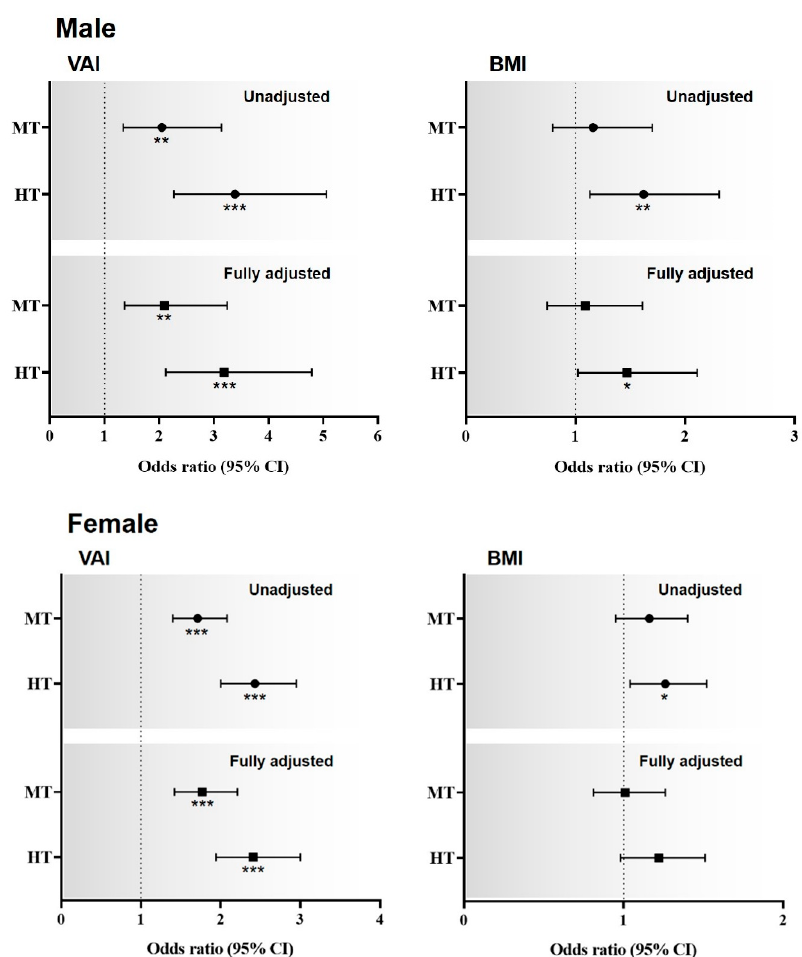
Figure 3. Sex-specific odds ratios for the relationships of MS CKD with the VAI and BMI Z-scores. Dotted line: reference; solid line: 95% confidence interval; Black circle: odds ratio. * p < 0.05, ** p < 0.01, *** p < 0.001 for the odds ratios for MS CKD, compared with the lowest quartiles. Abbreviations: HQ, highest quartile; MQ, middle quartile. VAI = visceral adiposity index; BMI = body mass index.